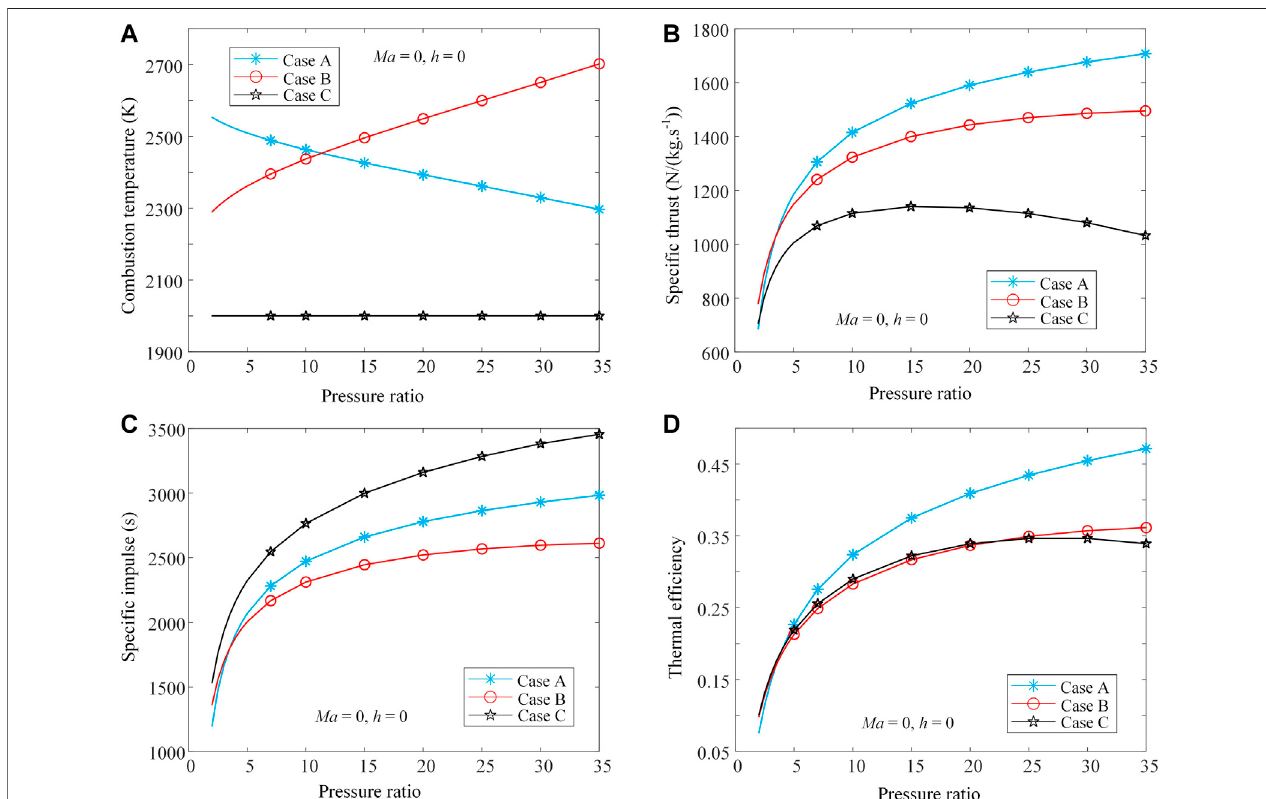
FIGURE 7 | Effects of pressure ratios on the (A) thermal ef fi ciency, (B) speci fi c thrust, (C) combustion temperature and (D) speci fi c impulse of the (Case A) HEFC engine and (Case B and Case C) turbojet engines.